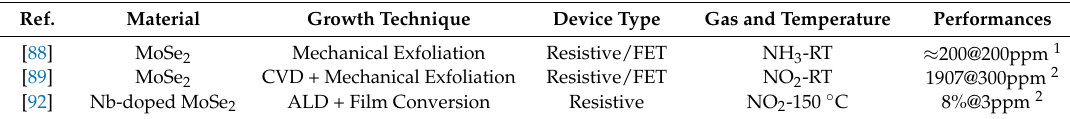
Table 3. Summary of MoSe 2 gas sensing devices, target chemical compounds and performances. RT stands for room temperature ( 1 in Ar atmosphere; 2 in N 2